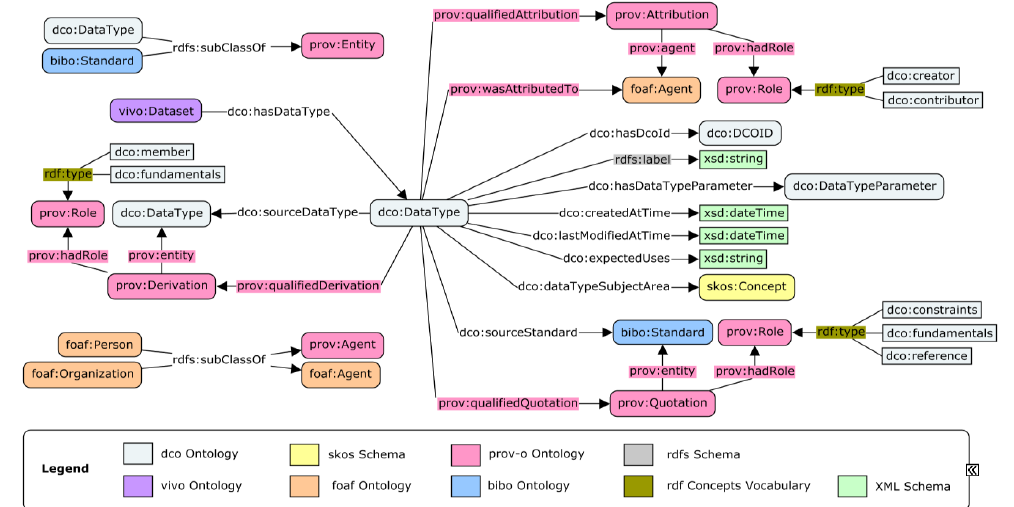
Figure 1. A conceptual model for the specification of data types.